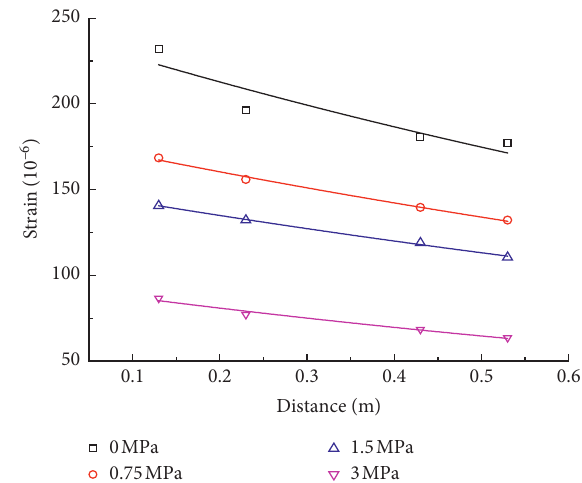
Figure 19: Physical attenuation law of cylindrical wave in intact rock mass under different confining pressures.